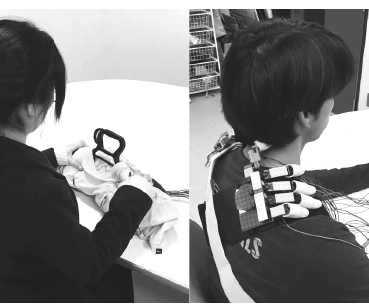
Figure 3: View of the sender device (left) and receiver device (right) during operation.